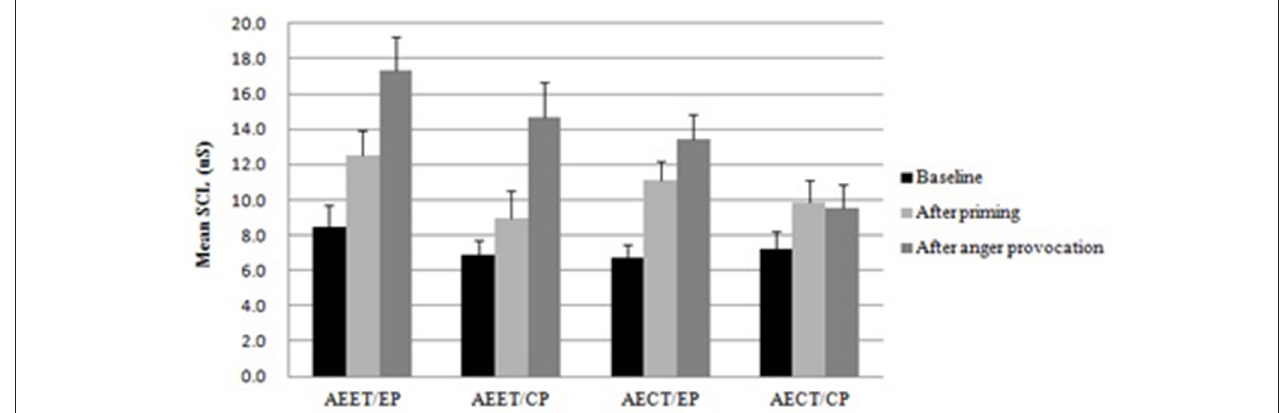
FIGURE 2 | Mean skin conductance levels for the four groups (AEET/EP, automatic emotion expression tendency/expression priming; AEET/CP, automatic emotion expression tendency/control priming; AECT/EP, automatic emotion control tendency/expression priming; AECT/CP, automatic emotion control tendency/control priming) across the three measurement points (baseline, after priming, after anger provocation; error bars represent standard errors of the mean).